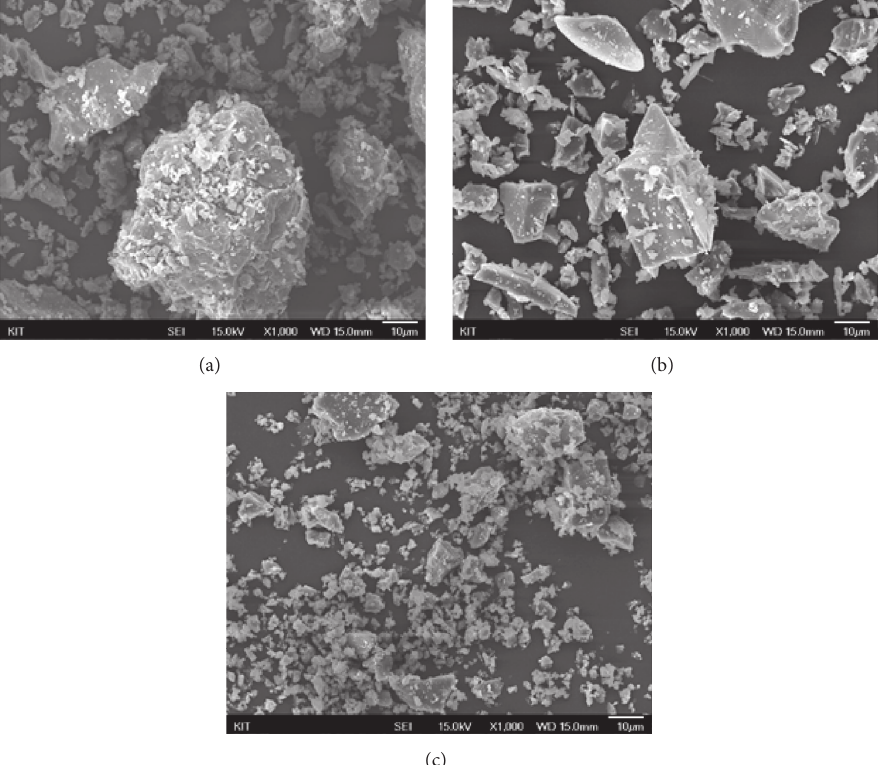
Figure 2: SEM images ( × 1,000) of (a) cement, (b) LGP12, and (c) LGP5.